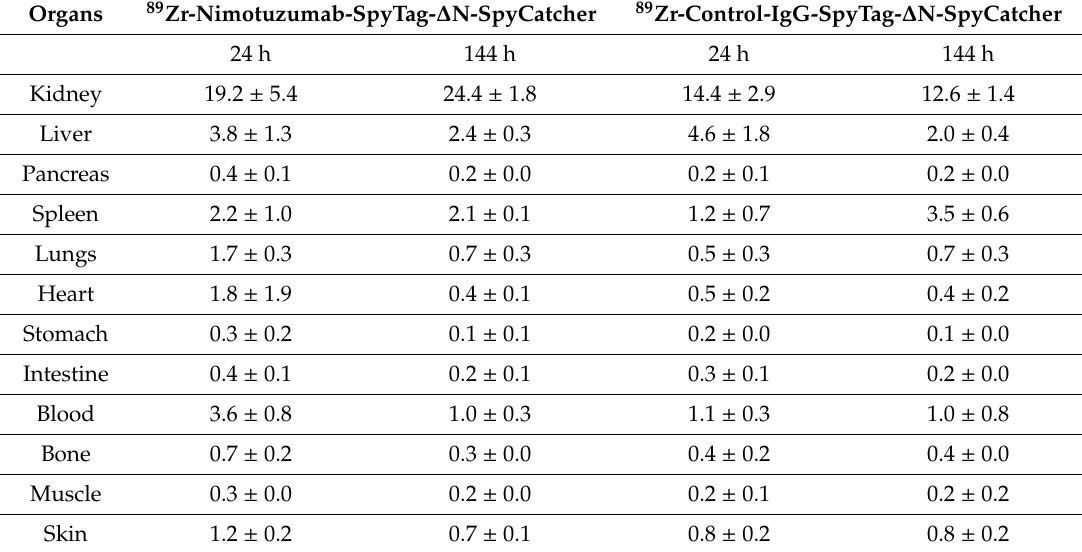
Table 1. Biodistribution of 89 Zr-nimotuzumab-SpyTag- ∆ N-SpyCatcher and 89 Zr-control-IgG-SpyTag- ∆ N-SpyCatcher in female athymic CD-1 nude mice ( n ≥ 3 per group), expressed as %IA / g ± SD.